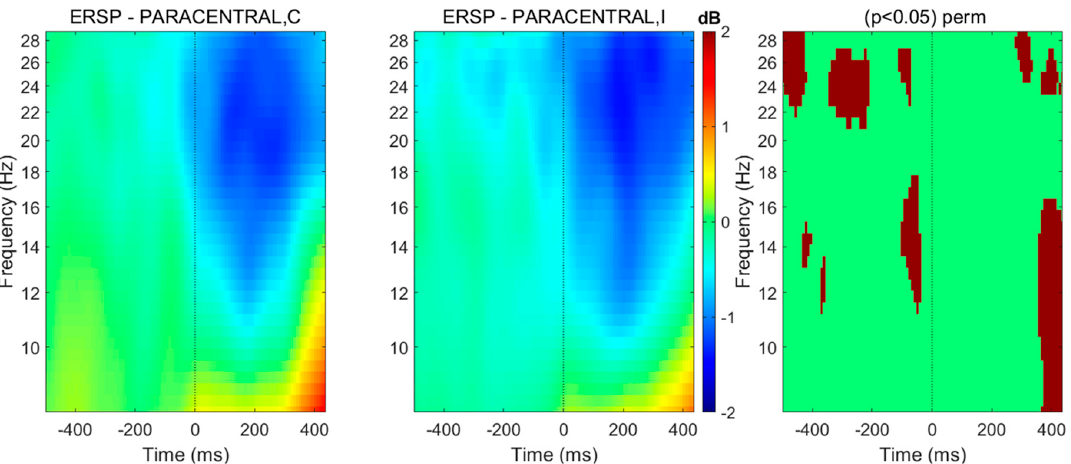
Figure 3. Spectral perturbations related to anticipatory postural adjustment onset located at paracentral lobules (right and left pooled), in case gait initiation is driven by a target surrounded by congruent (C) or incongruent (I) flankers. Using BRAINTSTORM toolbox [61], the head model was created from a standard MRI template and the boundary element method was used for calculating the leadfield matrix, whereas cortical sources were reconstructed thanks to weighted minimum-norm estimates before projecting the obtained dipole sources on 68 cortical regions from the Desikan-Killiany atlas. The spectral patterns were averaged over 30 healthy subjects. Spectral distribution among frequency bands from 4 to 30 Hz are shown. Right column: significant di ff erences in a permutation (perm) test (threshold at p < 0.05).